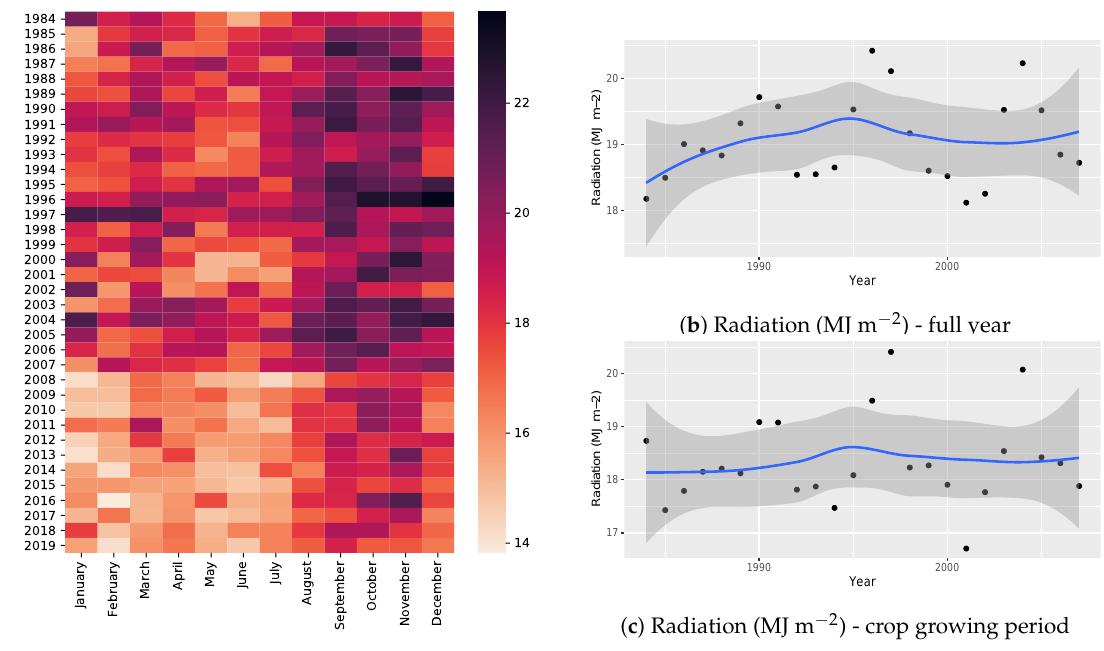
Figure A12. Time series of average radiation (MJ m − 2 ) in Loja. ( a ) Heat-map of radiation (MJ m − 2 ) per each month and year from 1984 to 2019. The color scale represents the radiation (MJ m − 2 ). ( b ) Radiation averaged during the full year from 1984 to 2007. ( c ) Radiation averaged during the maize crop growing period in Ecuador (January–May) from 1984 to 2007. Each dot represents one record, the blue line shows the smoothed time series and the shaded area represents the 95% confidence interval.